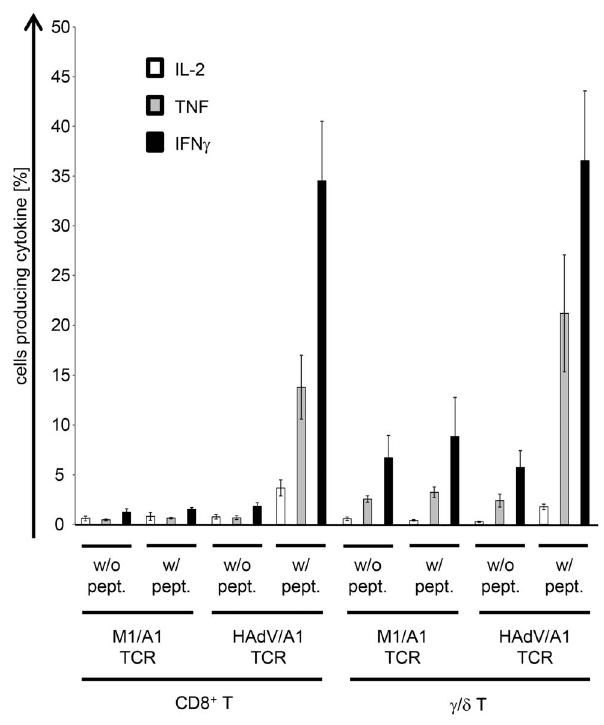
Figure 6. Antigen-specific cytokine production by HAdV/A1- TCR-transfected CD8 + and c / d T cells in response to peptide- loaded target cells. CD8 + T cells and c / d T cells were either electroporated with M1/A1-TCR RNA ( + CD8 a RNA in case of c / d T cells) or with HAdV/A1-TCR-RNA ( + CD8 a RNA in case of c / d T cells) and were cryoconserved 4 h after electroporation. After thawing, these cells were stimulated with CCL cells, which were either left unloaded (w/o pept.), or were loaded with the adenovirus peptide (w/pept.). Intracellular cytokine stainings for IL-2 (white bars), TNF (grey bars), and IFN c (black bars) were performed and analyzed by flow-cytometry. The percentages of cytokine containing cells are depicted. Average values of 4 (CD8 + T cells) and 3 ( c / d T cells) individual experiments 6 SEM are shown. Raw data are summarized in Table S6 in File S1.